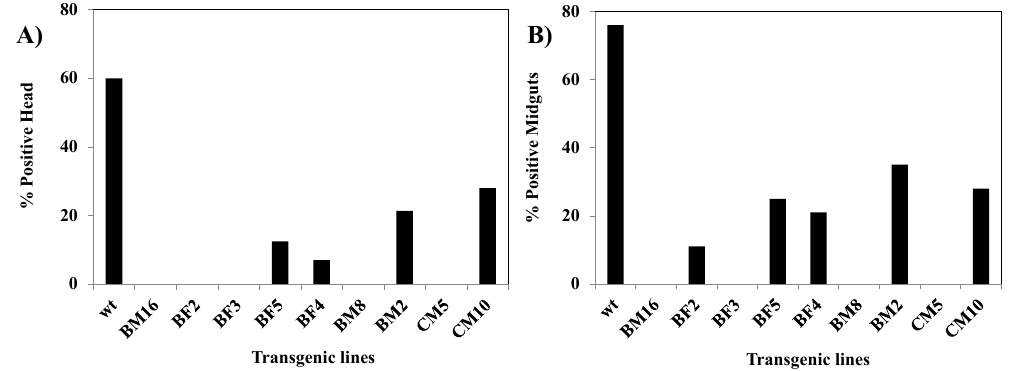
Figure 8. Indirect immunofluorescent assay preformed on G 7 transgenic females challenged with CHIKV. Seven dpi heads and midguts were dissected from both HWE and transgenic lines. ( A ) Shows the percentage of IFA-­‐‑positive head squashes; ( B ) Percentage of IFA-­‐‑positive midguts.